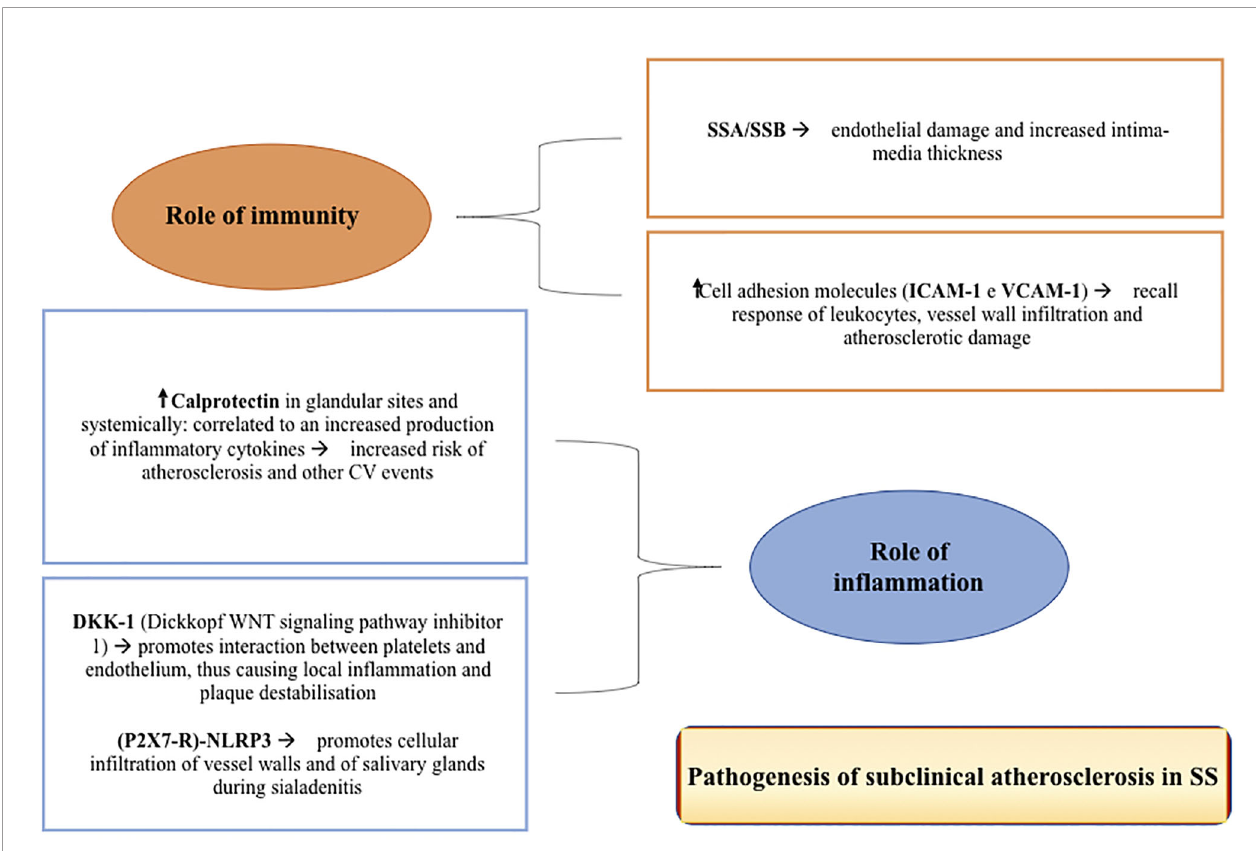
FIGURE 1 | The fi gure shows some of the main pathogenic mechanisms of subclinical atherosclerosis in Sjogren ’ s